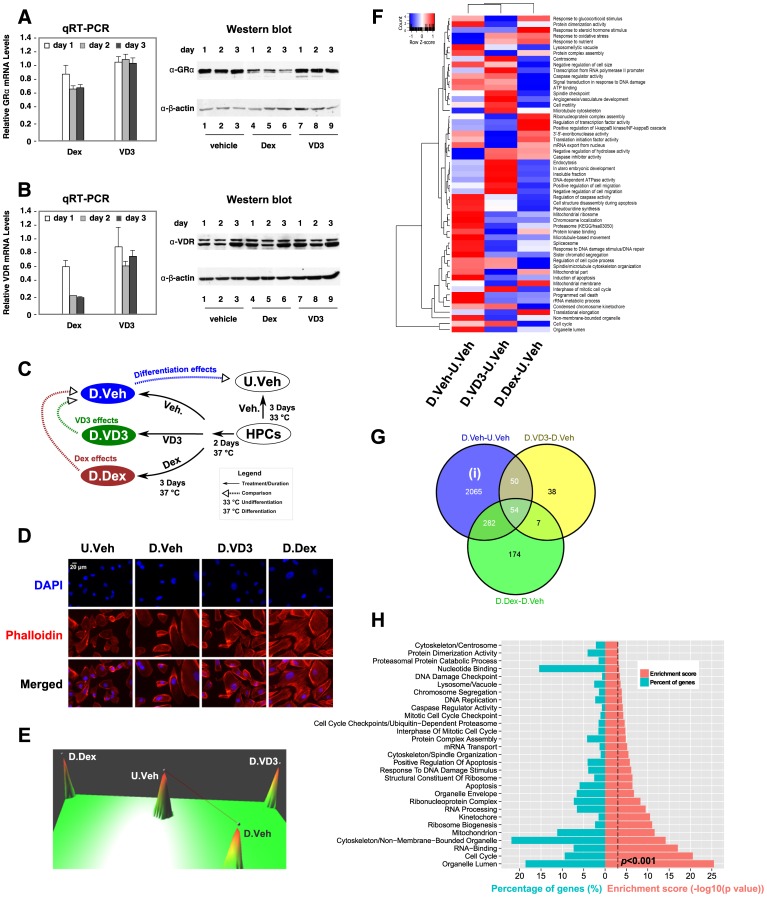
Microarray analysis of HPC differentiation.
A–B, HPCs were induced to differentiation according to a published protocol [12]. Two days after induction, cells were treated with vehicle, Dex or VD3. HPCs were harvested daily and total RNA was isolated and the accumulations of mRNA and protein of GRα (A) and VDR (B) were determined by qRT-PCR and Western blots, respectively. The relative mRNA expression is normalized by vehicle-treated samples. The β-actin was used as an internal Western loading control. (C) A schematic representation of the experimental design for microarray study. (D) The effects of hormone treatment on the morphology of differentiated HPCs. HPCs were treated as described in (C) followed by staining with rhodamine-labeled phalloidin and DAPI and visualized with fluorescent microcopy as described in Methods. Scale bar represents 20 µm. (E) A 3-D gene expression terrain map [52] of the sample relationship based on the significantly changed probes (>1.5 fold and q<0.05). The samples are represented by peaks and the correlation between samples is linked by lines with a correlation efficiency cutoff of 0.9. (F) Relative enrichment scores of the significantly influenced functional ontology information (P<0.01 in at least one of the comparisons) during HPC differentiation after vehicle or hormone treatments. (G) Comparison of the membership of the significantly changed genes (>1.5 fold, q<0.05). Genes (2065) representing the hormone-independent differentiation effects were designated as (i). The gene lists, D.Dex-D.Veh and D.VD3-D.Veh, represent the hormonal effects during HPC differentiation. (H) Significantly influenced functional categories (P<0.001) based on genes in (i) analyzed by DAVID as described in Methods. The percentage of genes (%) in the specific categories is also shown.